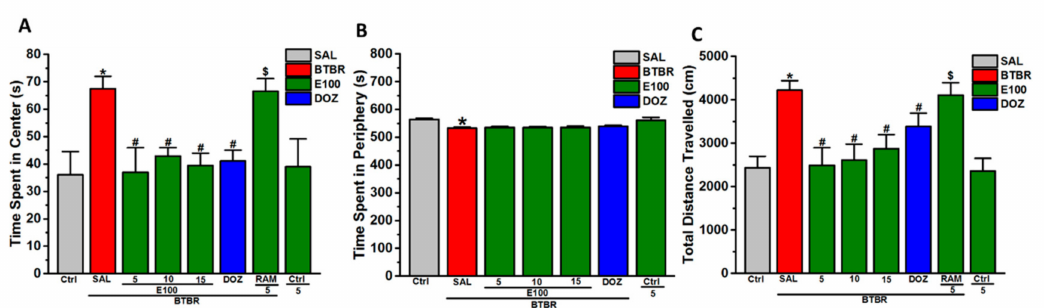
Figure 4. E100 and DOZ restored the abnormal anxiety and hyperactivity observed in BTBR mice in OFT. BTBR mice (red) demonstrated enhanced impulsive attitude and cognition deficits in as well as hyperactivity that was significant compared to Ctrl mice (gray). All mice were administered subchronically for 21 days with E100 (at a dose of 5, 10 or 15 mg / kg, i.p in green) or DOZ (1 mg / kg, i.p. in blue) and showed attenuation in the increased ( A ) time spent in the central zone as well as ( C ) the elevated total distance traveled, but failed to modulate the ( B ) time spent in the periphery in BTBR mice in the OFT. E ff ects of subchronic (21 days) systemic co-injection of RAM (10 mg / kg, i.p.) on the E100 (5 mg)-provided amelioration of time spent in the center and decreased ( C ) distance traveled of BTBR mice were evaluated in OFT. Data are expressed as the mean ± SEM (n = 4). * p < 0.05 compared to saline treated Ctrl mice. # p < 0.05 compared to saline treated BTBR mice. $ p < 0.05 compared to E100 (5 mg)-treated BTBR mice.